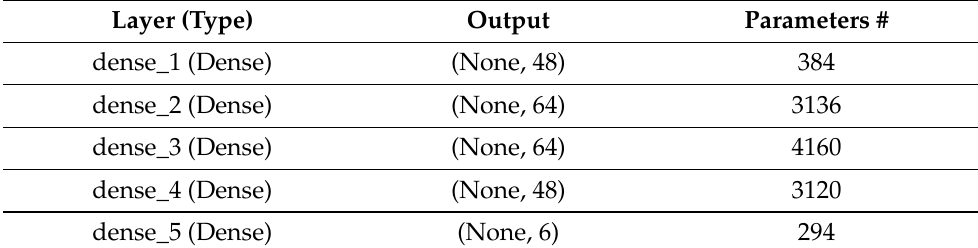
Table 5. Structure of the ANN for DRL Model 3.